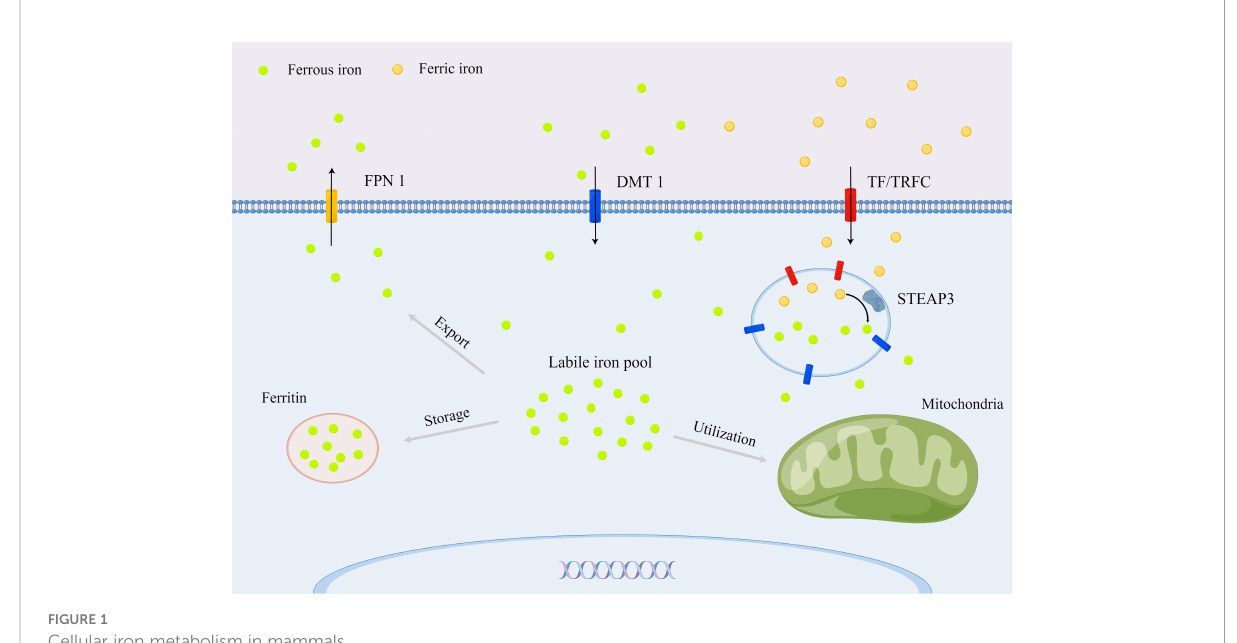
FIGURE 1 Cellular iron metabolism in